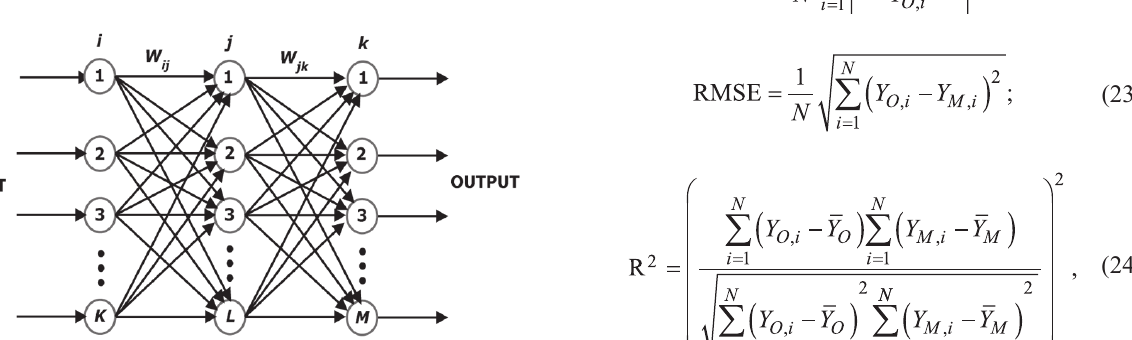
Fig. 3. Schematic diagram of MLP architecture